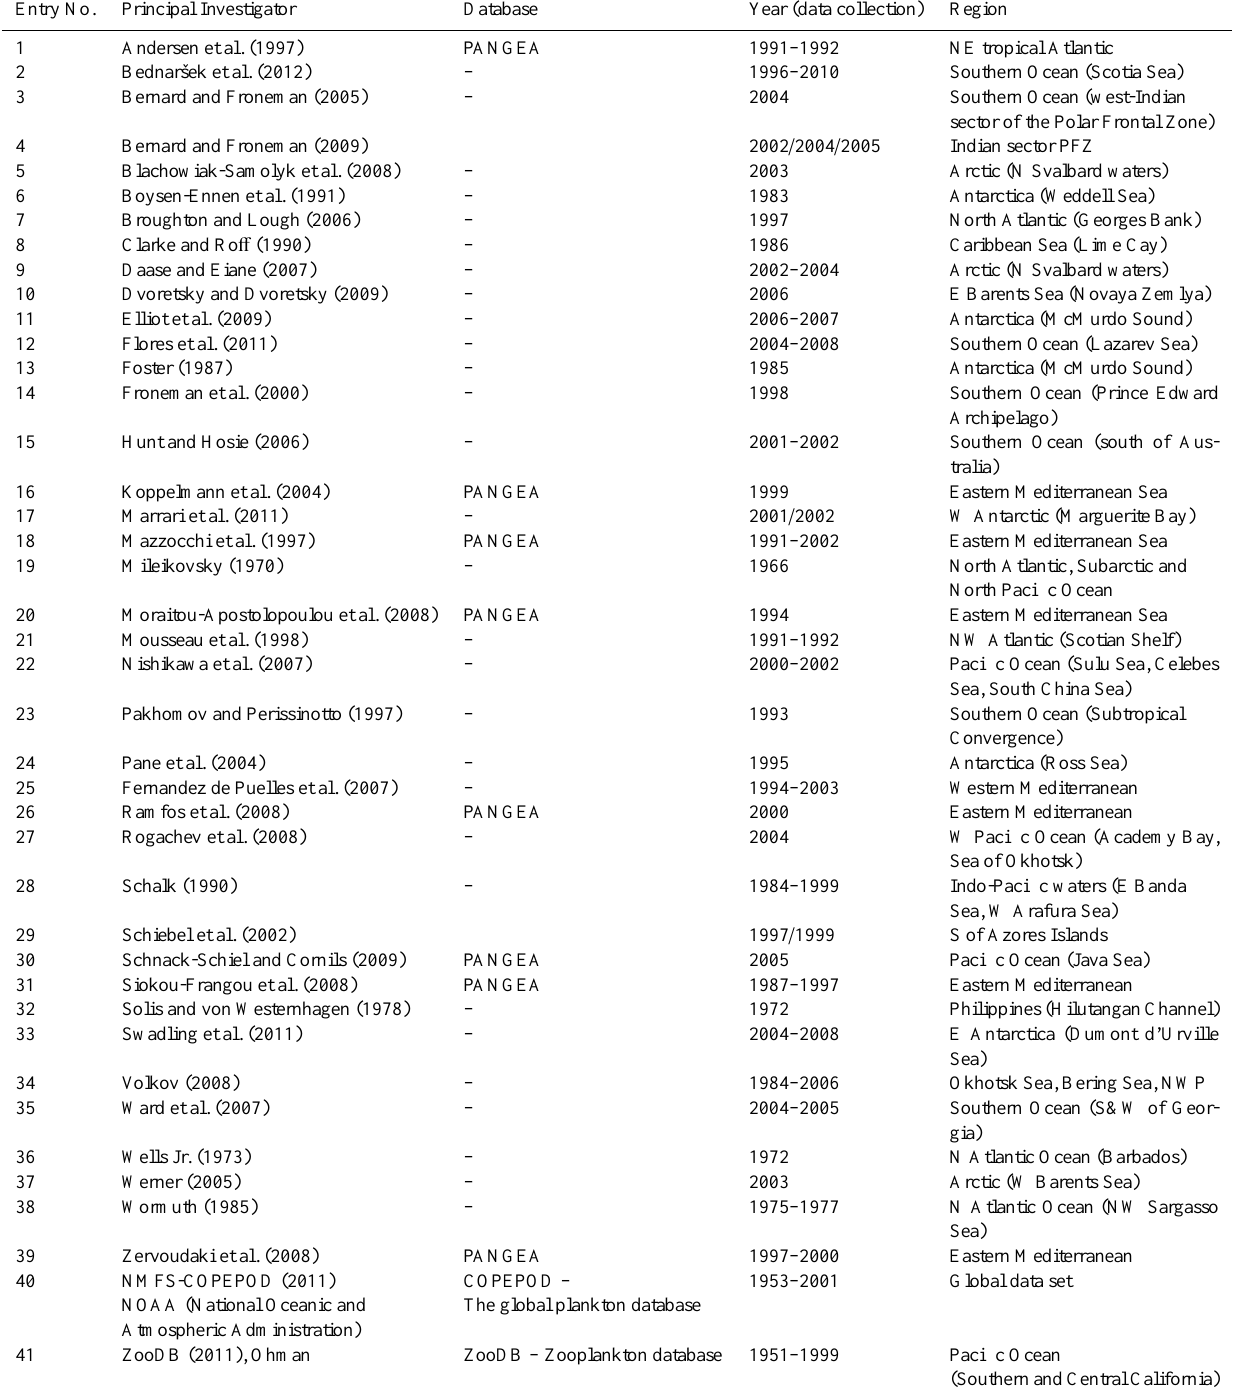
Table 1. The list of data contributors in alphabetical order, with the two major online databases listed at the end of the list. Entry